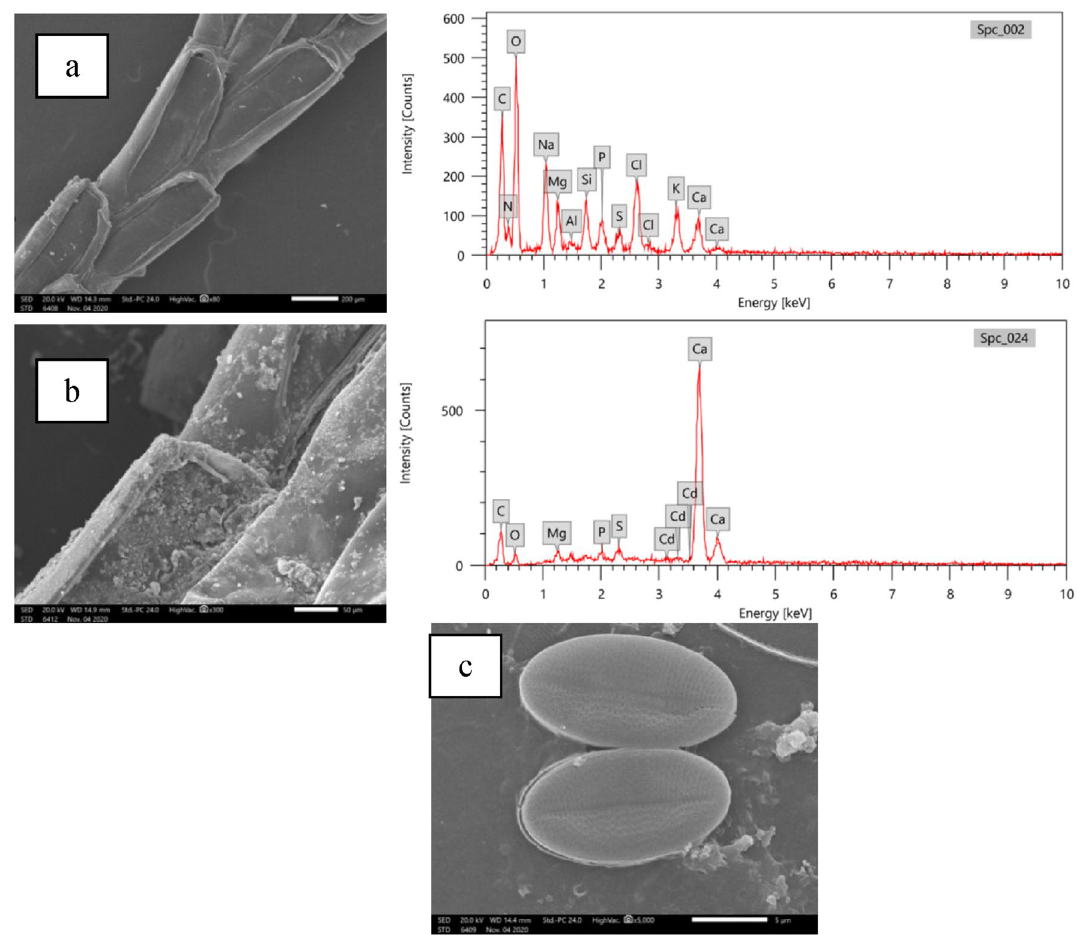
Figure 4. SEM images and EDX spectra of IABB, ( a ) before Cd(II) biosorption, ( b ) after Cd(II) biosorption, and ( c ) unloaded